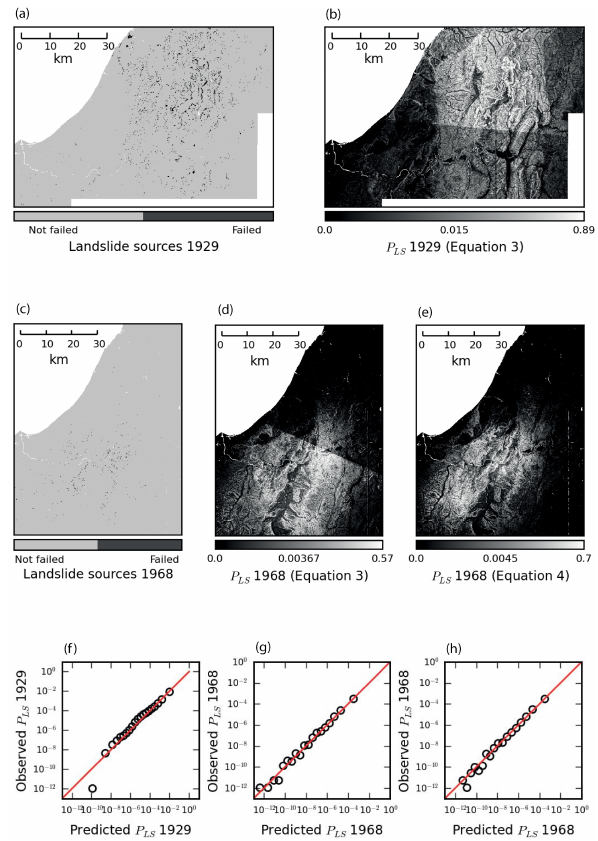
Figure 11. Comparison of observed and predicted distributions of hillslope failure. 1929 earthquake: (a) input map of hillslope fail- ures and (b) output map of predicted P LS from Eq. (5). 1968 earth- quake: (c) input map of hillslope failures, (d) output map of pre- dicted P LS from Eq. (5) (fault distance model) and (e) output map of predicted P LS from Eq. (6) (PGA model). Plots of observed vs. predicted P LS : (f) 1929 earthquake, Eq. (5); (g) 1968 earthquake, Eq. (5); and (h) 1968 earthquake, Eq. (6). These data are gener- ated by aggregating probabilities across 20 equal quantile bins of the predicted P LS